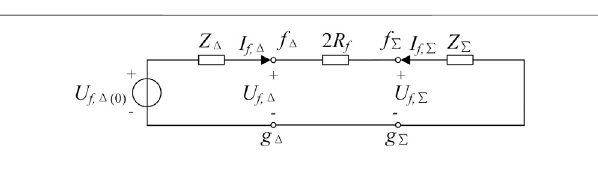
FIGURE 12 | The equivalent CDM network under single-pole grounding